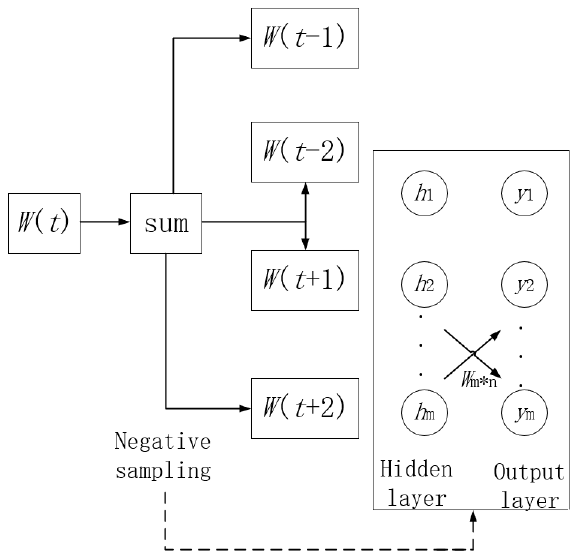
Figure 4. The Structure Of Skip-gram+Negative